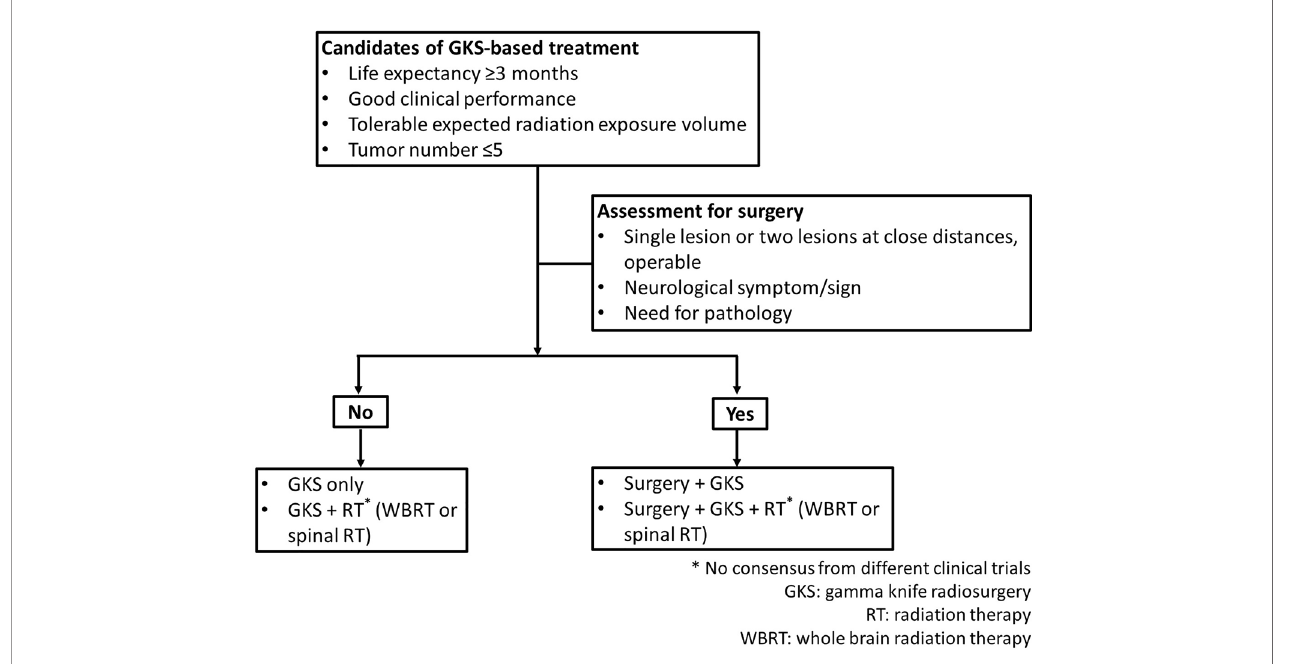
FIGURE 1 | Assessment for GKS-based treatment strategies in clinical